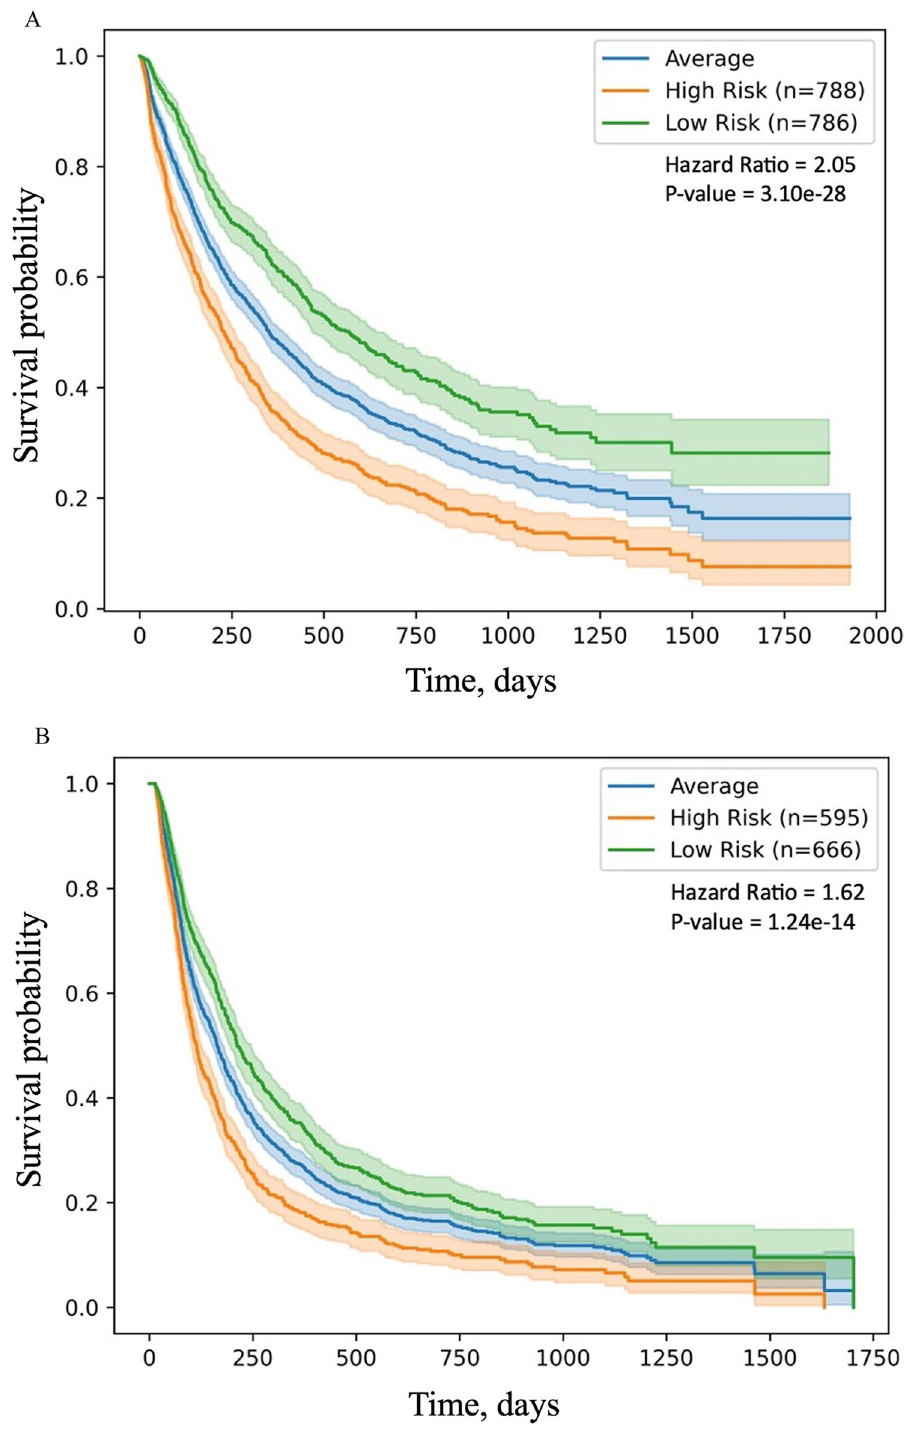
Figure 2. Kaplan–Meier curves for risk stratification. ( A ) Gradient-boosted Cox proportional hazard model for overall survival. ( B ) Gradient-boosted Cox proportional hazard model for progression-free survival. The average curves were generated using observed survival